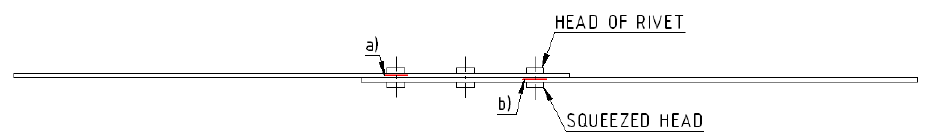
Figure 5. Examples of crack morphology: through-hole ( a ) and in proximity of the hole ( b ).